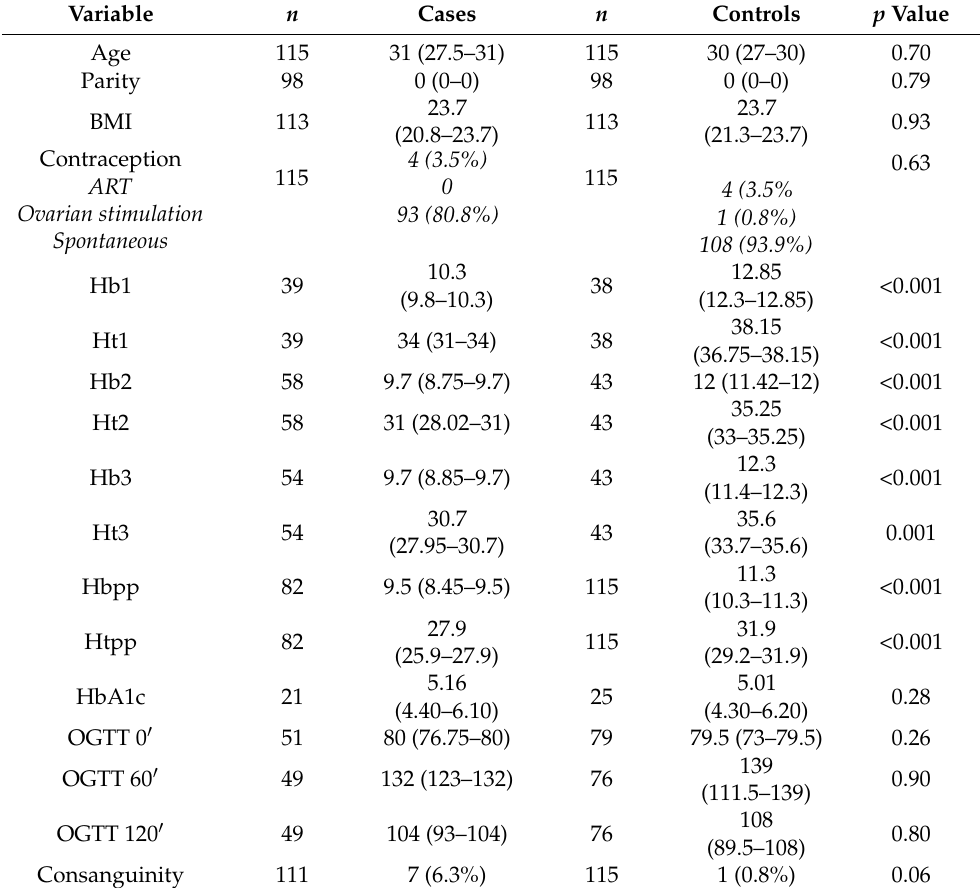
Table 1. Baseline characteristics of the 230 study participants with and without beta-thalassemia minor.